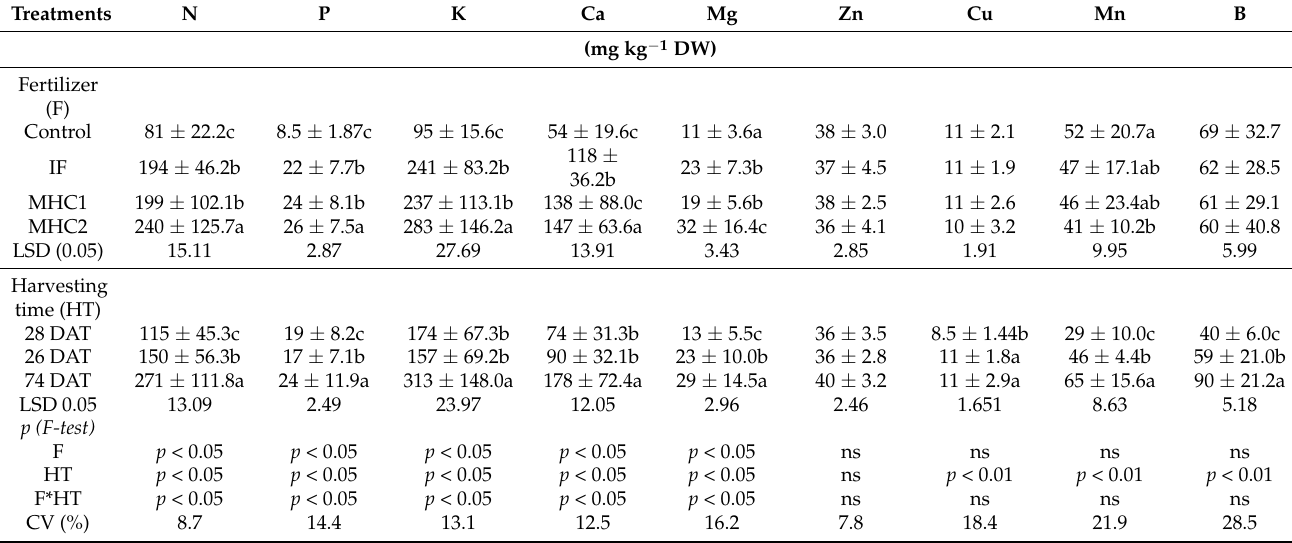
Table 4. Effect of macadamia husk compost and inorganic fertilizer on leaf nutrient concentration in